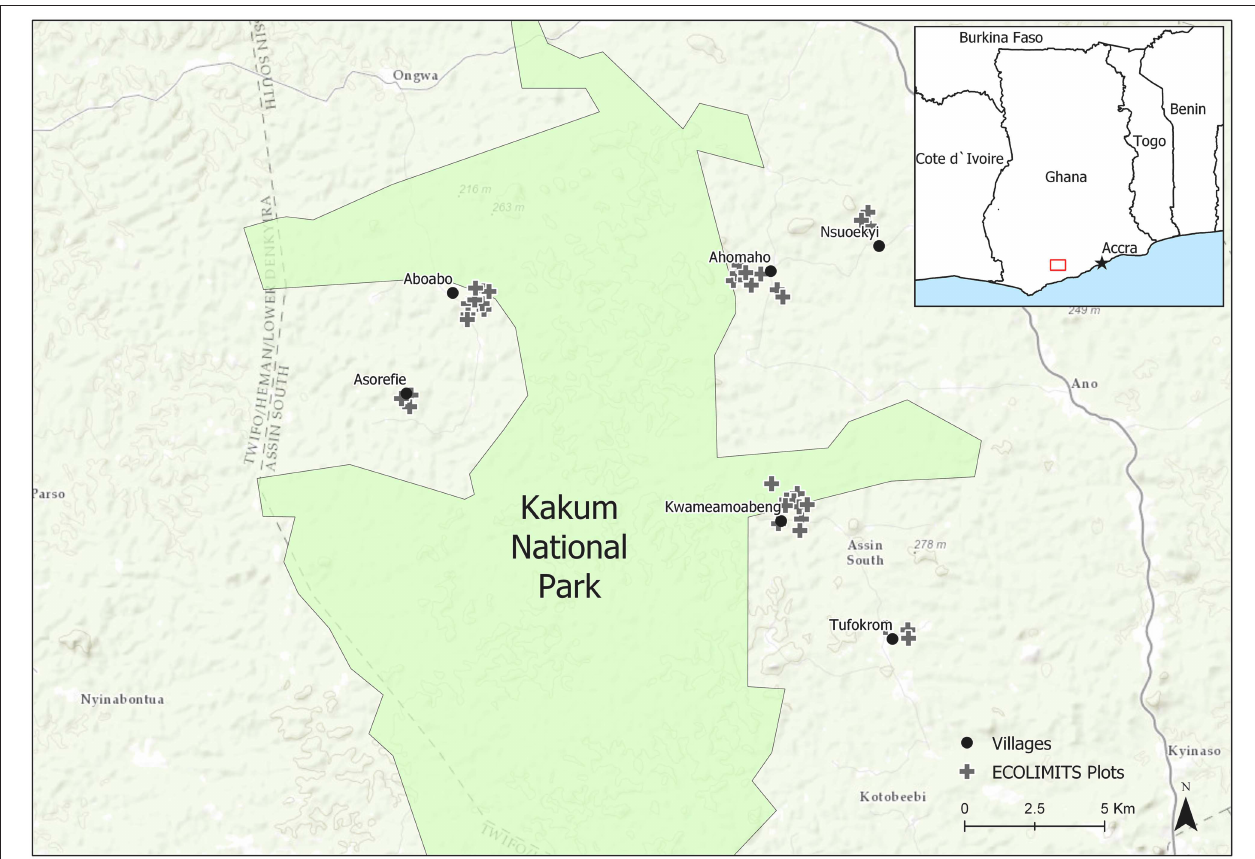
FIGURE 2 | Study sites for the ECOLIMITS project surrounding Kakum National Park in southern Ghana. ECOLIMITS ecological plots ( + ) were intensively monitored for 3 years between 2014 and 2017. Six villages ( • ) where the household surveys for the ECOLIMITS project were